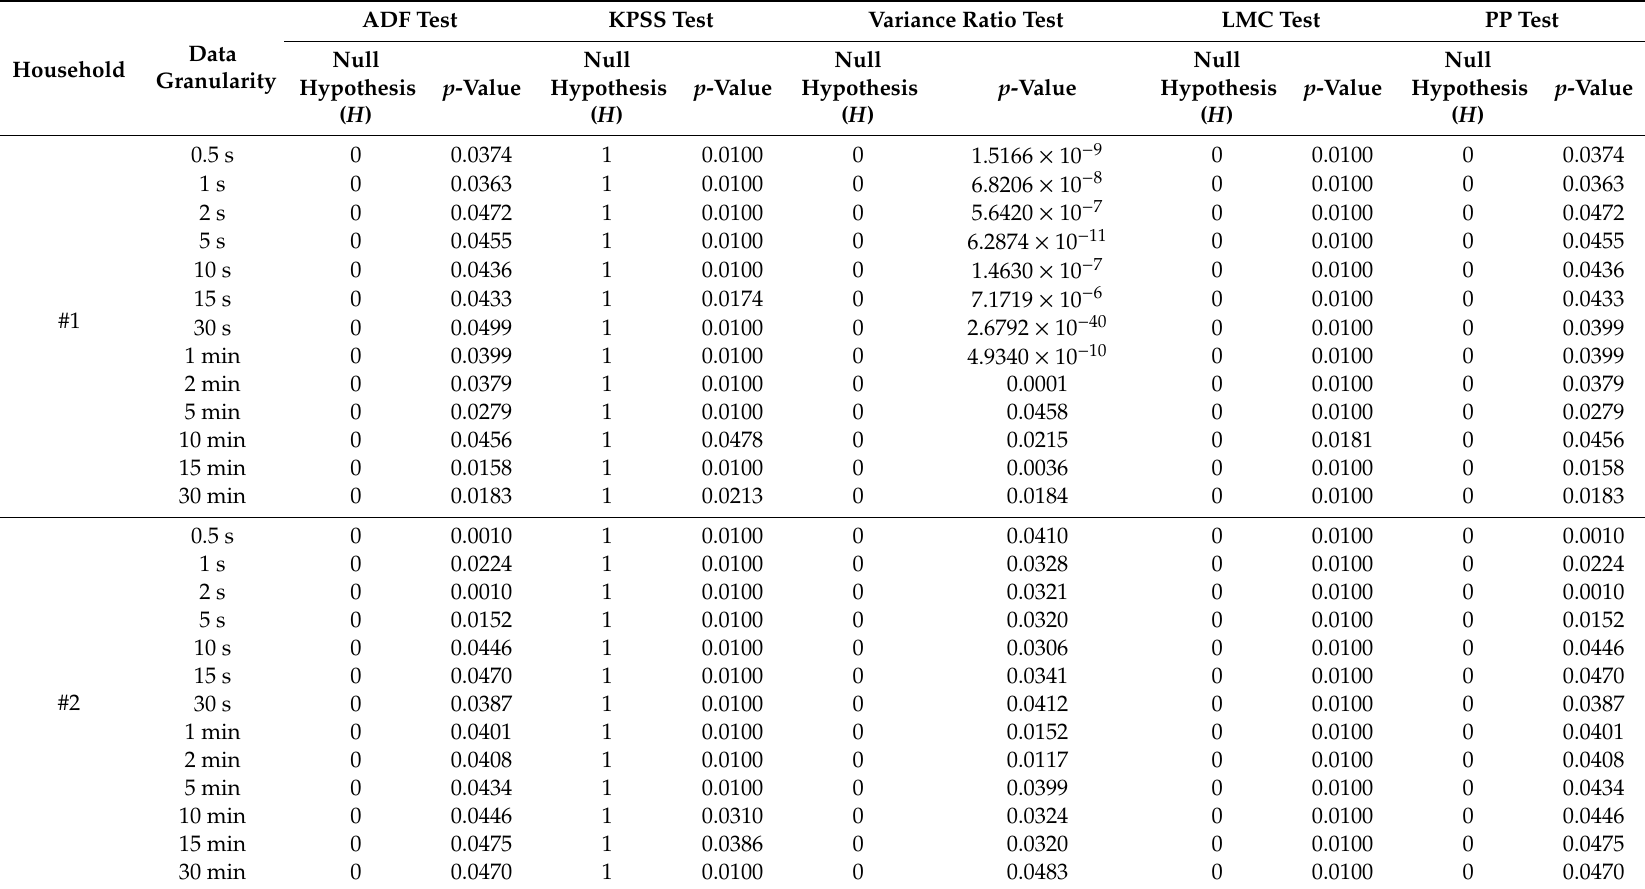
Table 6. Statistical tests to check stationary of the consumption load